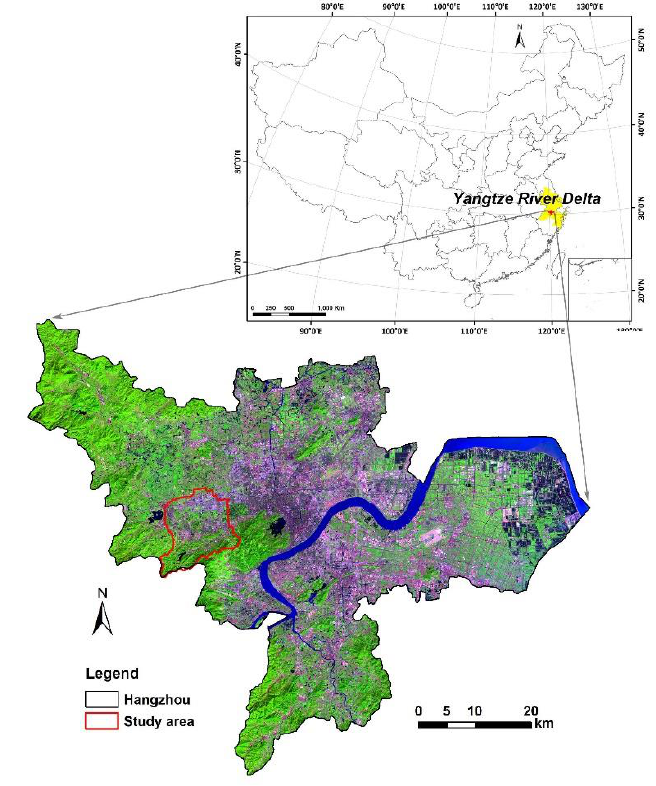
Figure 1. Locations of the study area.